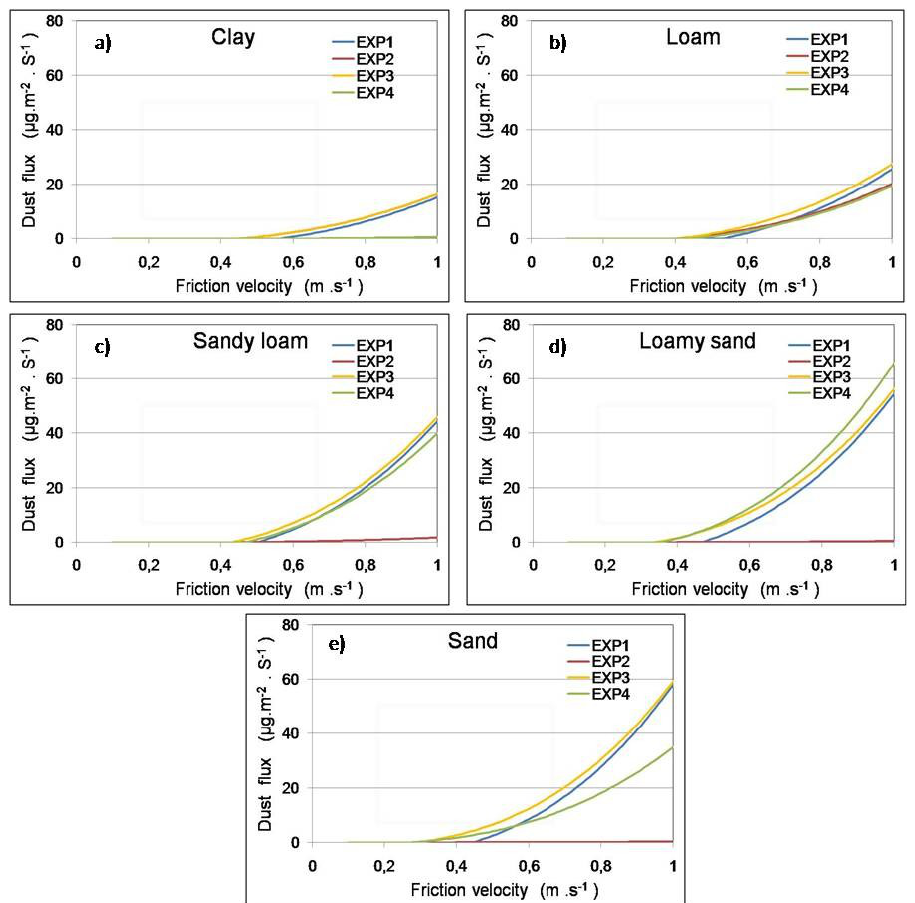
Fig. 7. Evolution of the surface dust fluxes (in µ gm − 2 s − 1 ) depending on the friction velocity (ms − 1 ) over: (a) Clay soil (b) loam soil, (c) sandy loam soil, (d) loamy sand soil, and (e) sand soil.